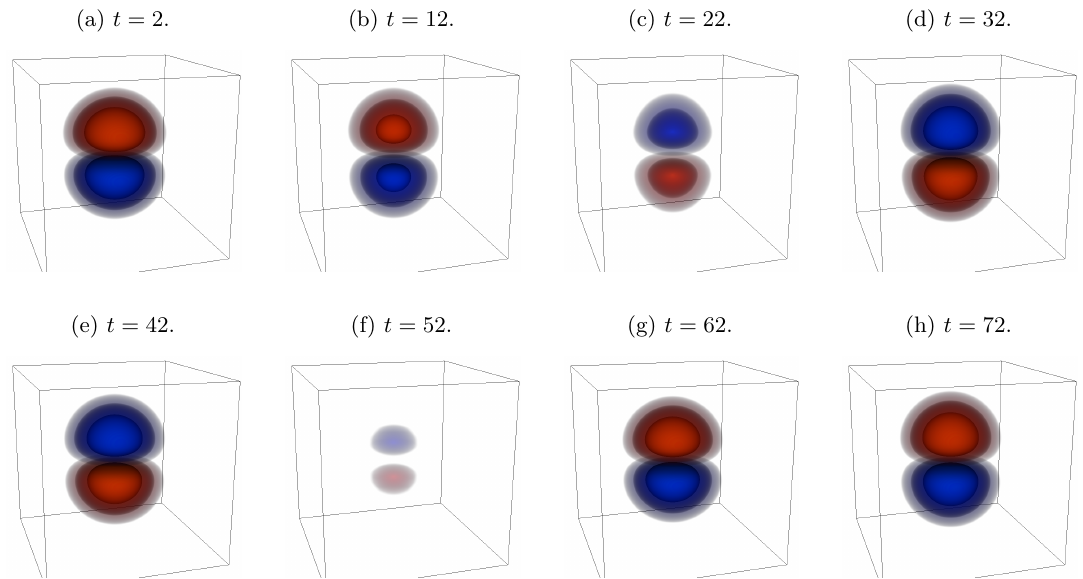
Figure 6 . Evolution sequence of the charge density of a dipole CSQ. The energy density, which is not plotted, remains mostly spherically symmetric. The red and blue color denote positive and negative charges respectively. This sequence is extracted after the CSQ has evolved for a period of 1000 . The plots cover about 1 / 8 of the whole 3D lattice.